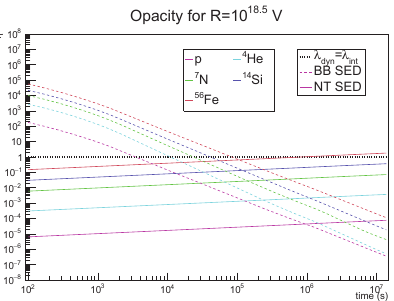
Figure 2. Source opacity for several nuclei with rigidity R = 10 18 . 5 V obtained with the photon SEDs in Figure 1. The escape condition is given by the black dashed line.